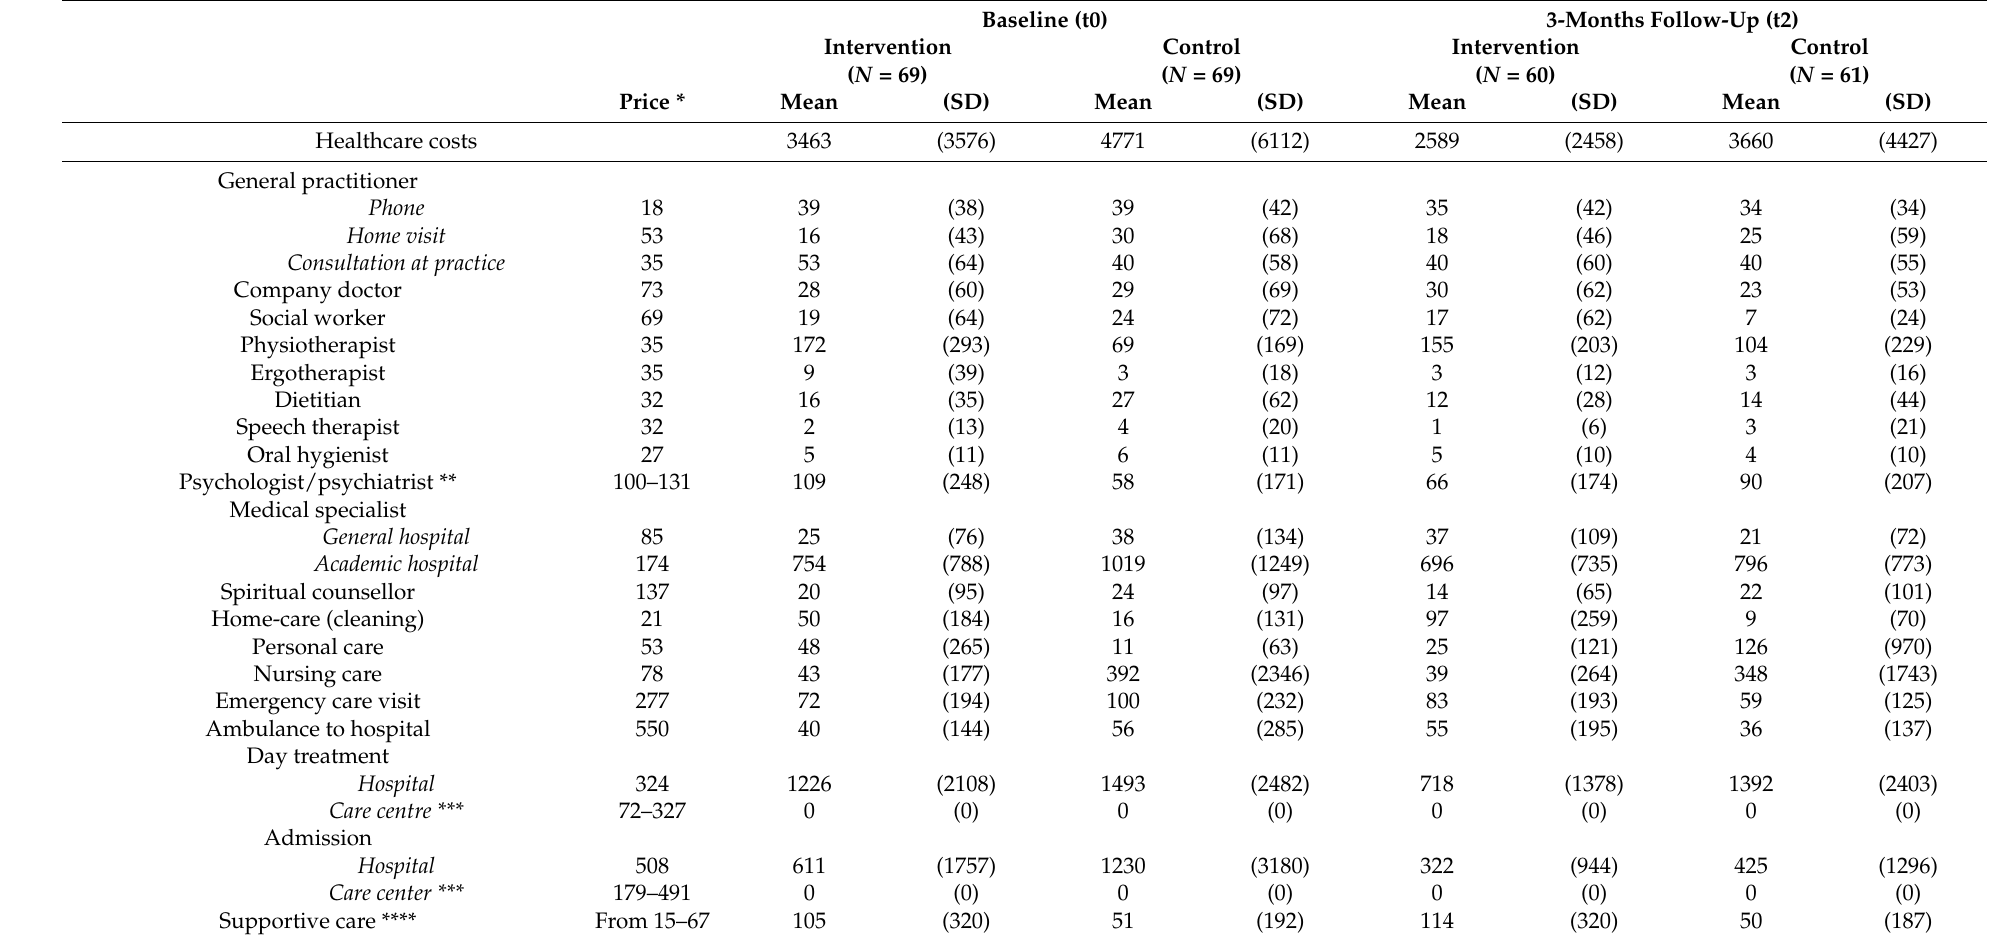
Table 2. Mean costs per time point at t0 and